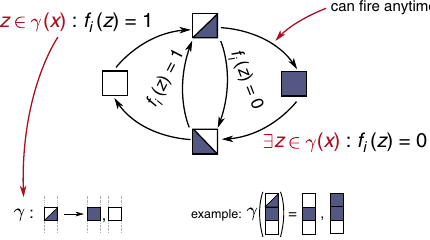
Fig. 3 Allowed changes of component states in Most Permissive Boolean Networks. Conditions are expressed for a component i ∈ {1, … , n } from a most-permissive con fi guration x ∈ {0, ↗ , ↘ , 1} n . The increasing state ↗ is represented by a top-left white and bottom-right blue square, the decreasing state ↘ by a bottom-left blue and top-right white square. The function γ gives the admissible Boolean interpretations of x : γ ð x Þ ¼ f z 2 B n j8 i 2 f 1 ; ¼ ; n g ; x i 2 B ) z i ¼ x i g , i.e., all the components in Boolean states are fi xed, and the others are free.